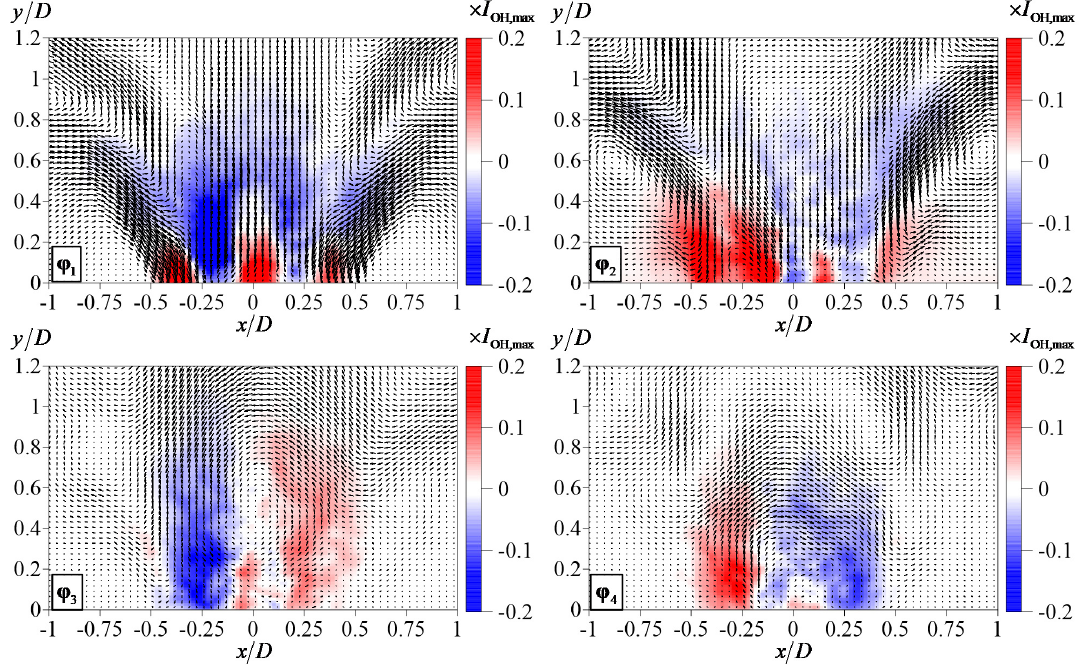
Figure 10. First four POD modes with phase-averaged OH PLIF intensity for syngas flame at elevated conditions.